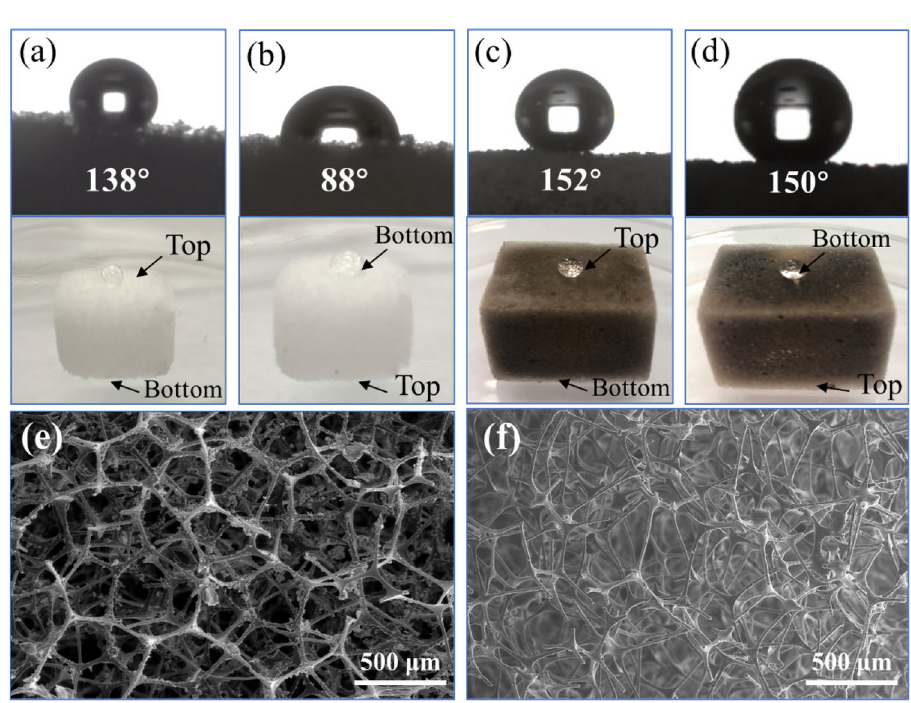
Figure 9. ( a ) WCA at the top of OTS-MS; ( b ) The WCA at the bottom of OTS-MS; ( c ) The WCA at the top of OTS-PDA-MS; ( d ) The WCA at the bottom of the OTS-PDA-MS; ( e ) the SEM image of OTS-PDA-MS; ( f ) the SEM image of